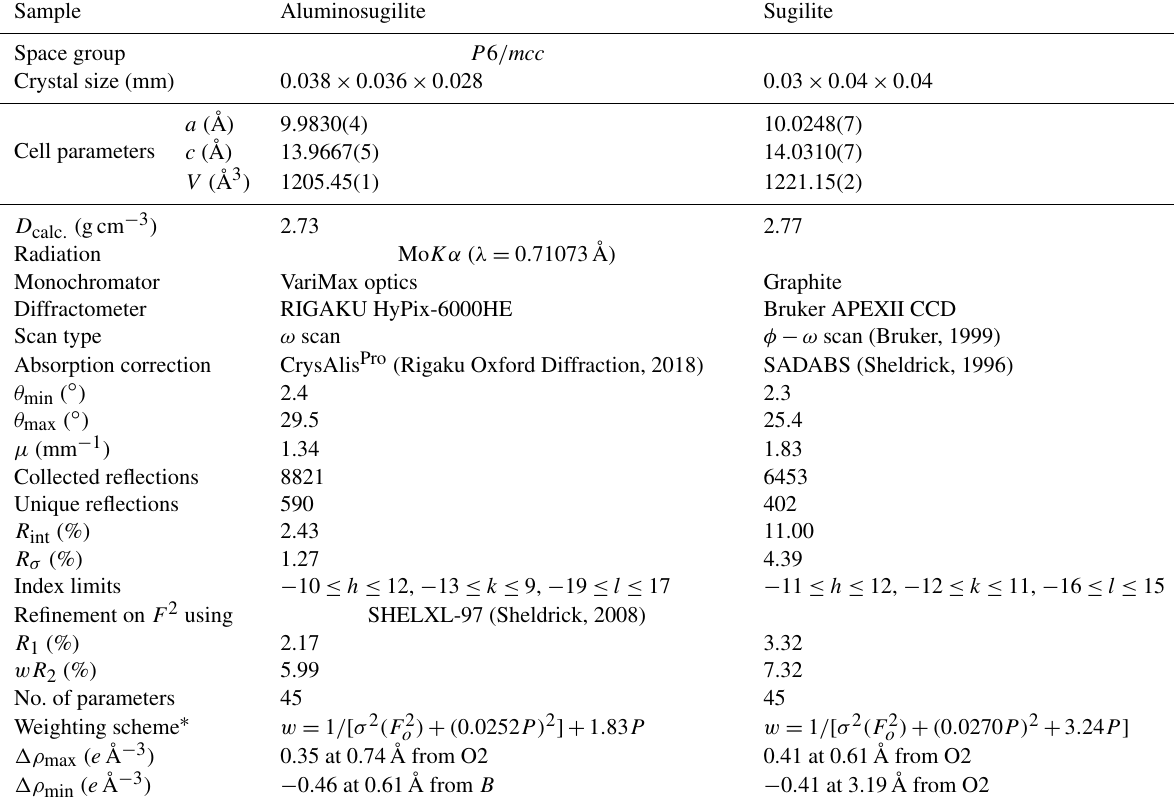
Table 2. Experimental details of the single-crystal X-ray diffraction analysis of aluminosugilite and sugilite crystals.